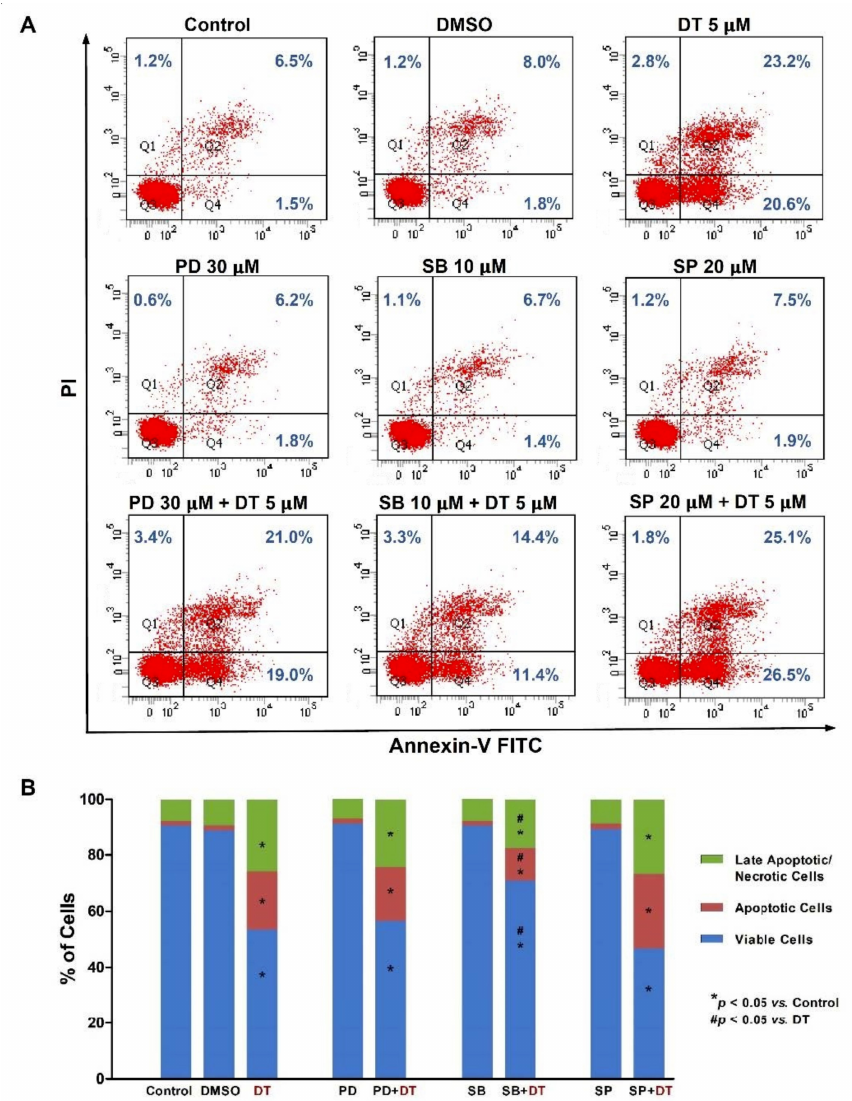
Figure 7. p38 Signaling regulated DT-induced apoptosis in Detroit 562 cells. ( A ) Cells were pretreated with specific kinase inhibitors of ERK1/2 (PD98059, 30 µ M), p38 (SB203580, 10 µ M), or JNK (SP600125, 20 µ M) for 1 h and then treated with 5- µ M DT for 24 h; the percentages of viable cells, apoptotic cells, and late apoptotic/necrotic cells were determined by annexin V/PI staining followed by flow cytometric analysis. ( B ) The distributions of viable, apoptotic, and late apoptotic/necrotic cells after treatment were calculated from the means from three independent experiments. * and # indicate statistically significant differences compared with untreated control cells and 5- µ M DT-treated cells,